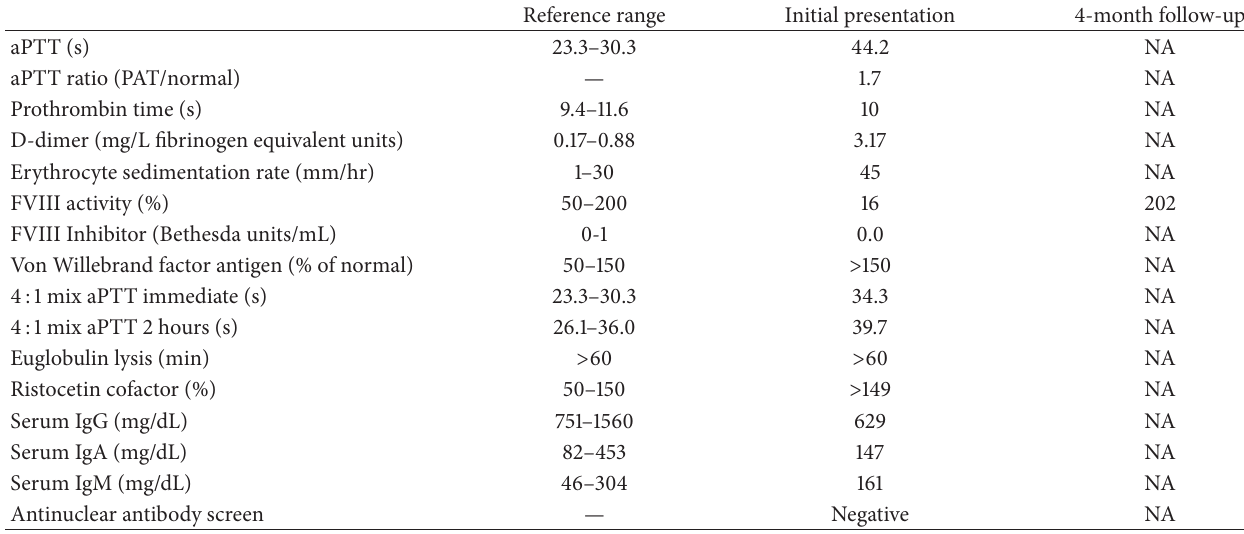
Table 1: Laboratory work-ups at the initial presentation and after 4 months of follow-up.